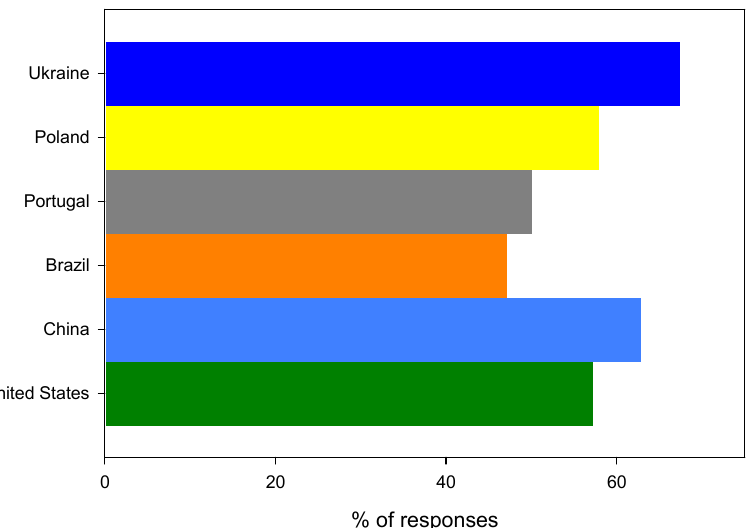
Figure 5. The distribution of negative answers to the question: Did you know that bioplastics can be made from leftovers of bakery and confectionery products (e.g., bread, cakes . . . )? Table 4. ANOVA statistical analysis for the response surface linear model of the % of negative answers to the question “Did you know that bioplastics can be made from leftovers of bakery and confectionery products (e.g., bread, cakes . . . )?” in the function of the education of questionees. Model β 1 β